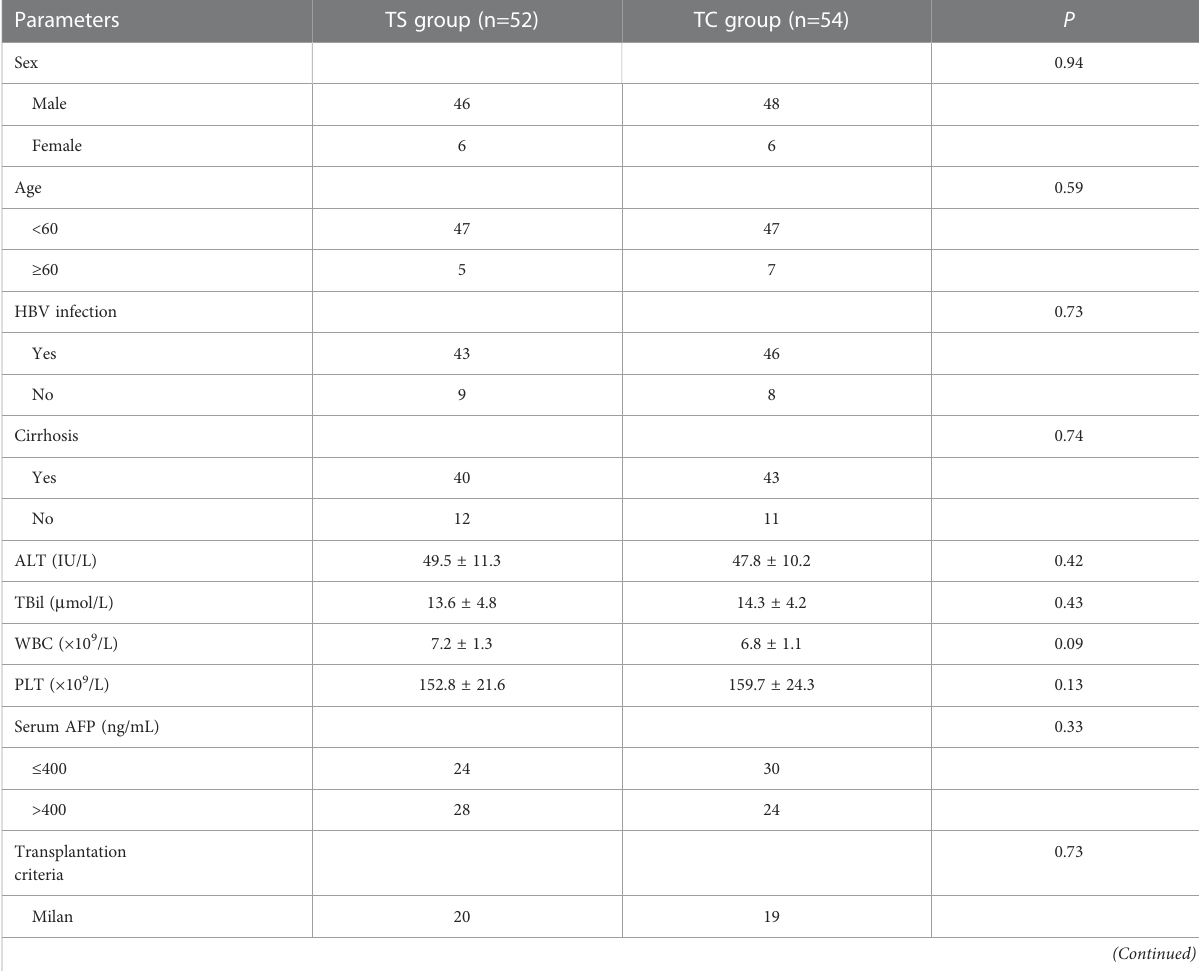
TABLE 1 Baseline characteristics of patients in the TS and TC